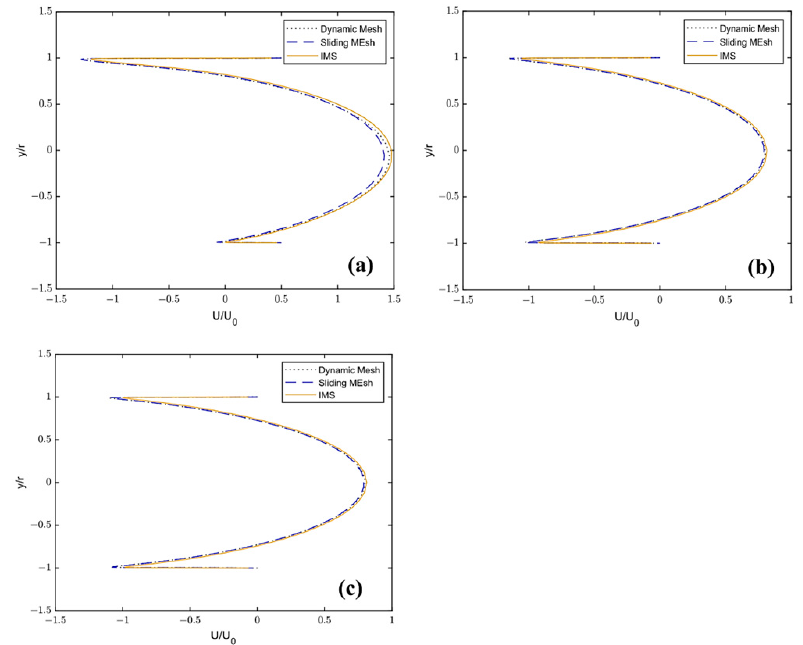
Figure 14. Axial velocity profile at the vertical line with distances of: ( a ) 25cm; ( b ) 50 cm; ( c ) 75 cm upstream of the valve at the end of the valve closure.